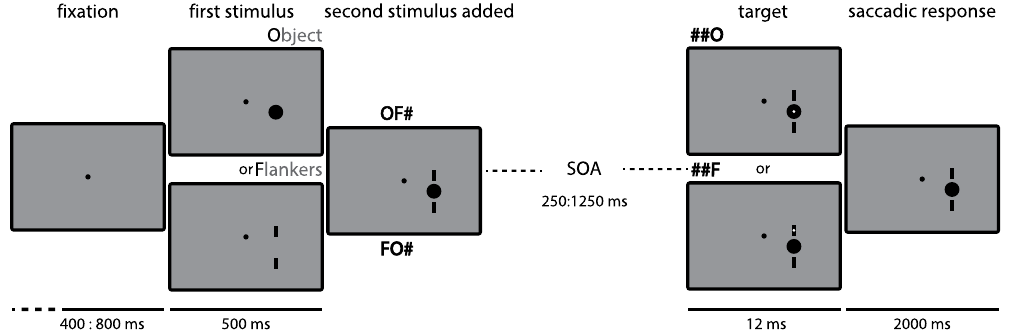
Figure 1. Experimental Protocol. Trials started with a fixation period during which participants maintained fixation for a variable delay between 400 to 800 ms. Following the fixation period the first stimulus (object or flanker) was presented for 500 ms after which a second object (flanker if object first (OF#) and vice versa (FO#)) was added. After a variable SOA of 250 to 1250 ms (in steps of 12 ms) a target was presented for 12 ms, either in the center of the object (##O) or in the flanker (##F). Participants were instructed to respond to the target with a saccade towards the stimulus in which it